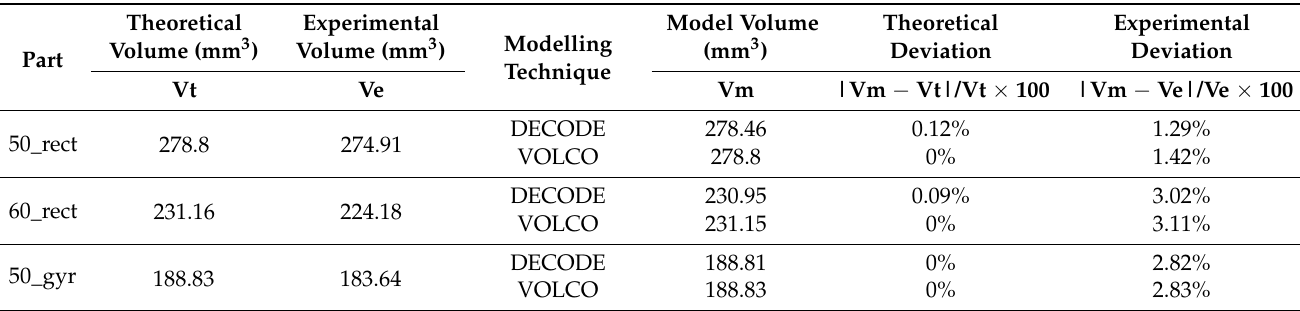
Table 9. Comparison of